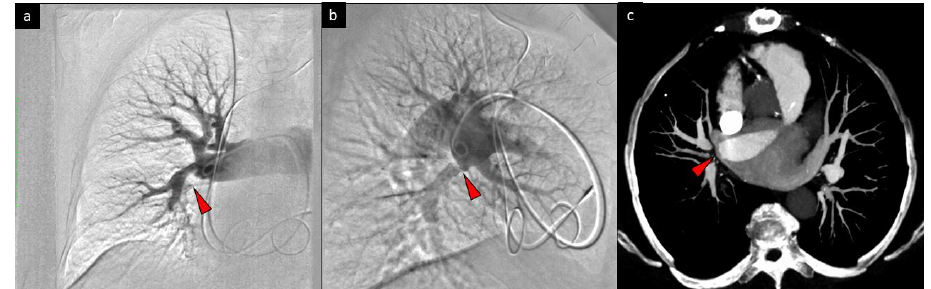
Figure 1. Angiography of the right pulmonary artery with a proximal thromboembolic lesion (marked by the red arrow) in the anteroposterior view ( a ), lateral view ( b ), and computed tomography ( c ).